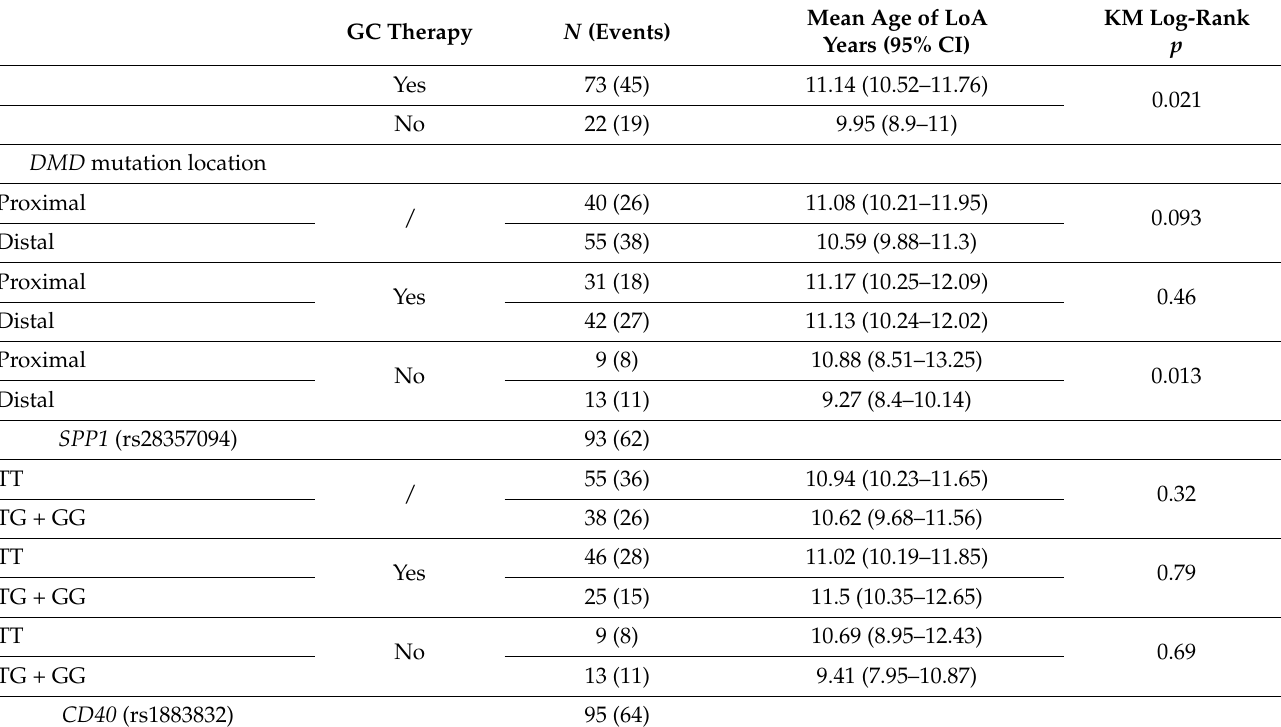
Table 1. Mean age at loss of ambulation (LoA) in DMD patients, stratified by glucocorticoid (GC) therapy, DMD mutation location, SPP1 and CD40 genotypes, and LPTB4 haplotypes. GC Therapy N